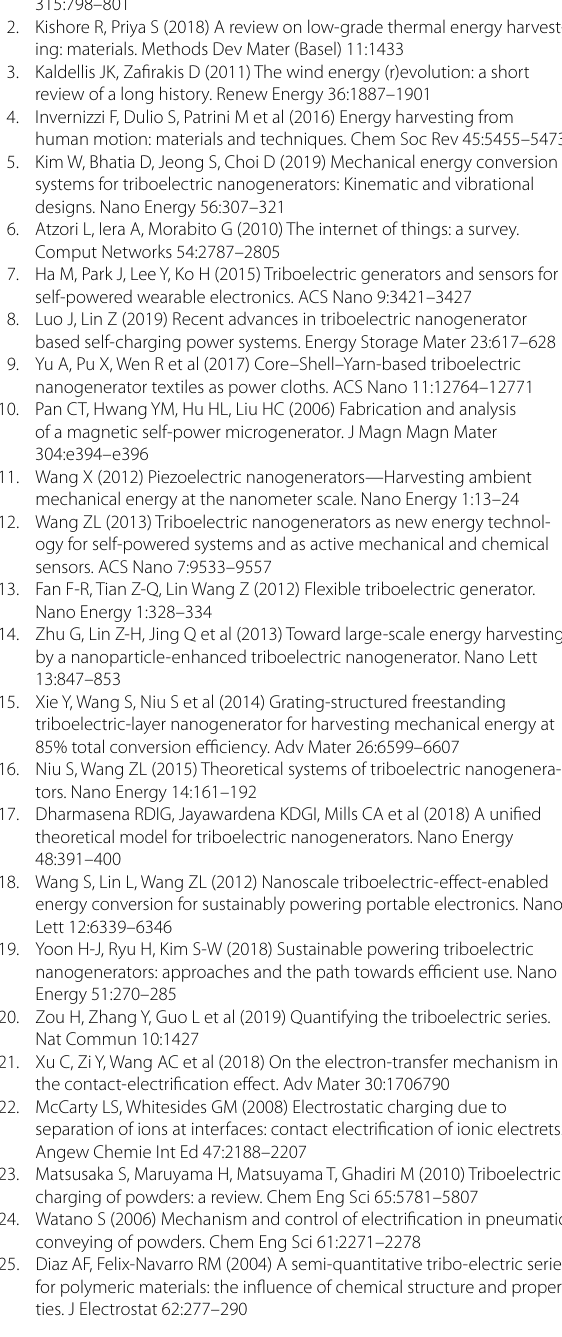
Structural figure of merit; FOTS: (1H,1H,2H,2H-perfluorooctyl)silane; FSTENG: Free standing triboelectric nanogenerator; GO: Graphene oxide; HD-MN-TENG: High density microneedles triboelectric nanogenerator; H-P/TENG: Hybrid piezoelectric-triboelectric nanogenerator; HTMS: Hexyltrimethoxysilane; IBTENG: Infusible biomass-based triboelectric nanogenerator; IoT: Internet-of- Things; I sc : Short-circuit current; ITO: Indium tin oxide; Jsc: Short circuit